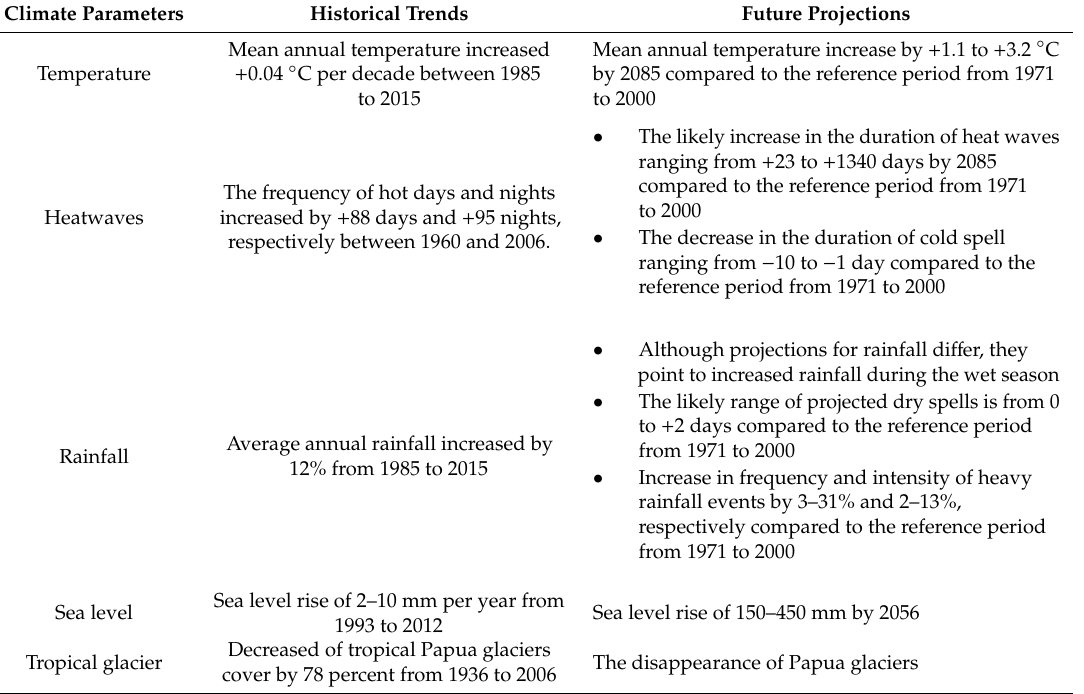
Table A1. Historical trends and future projections of the Indonesian climate. Source: [46,50].